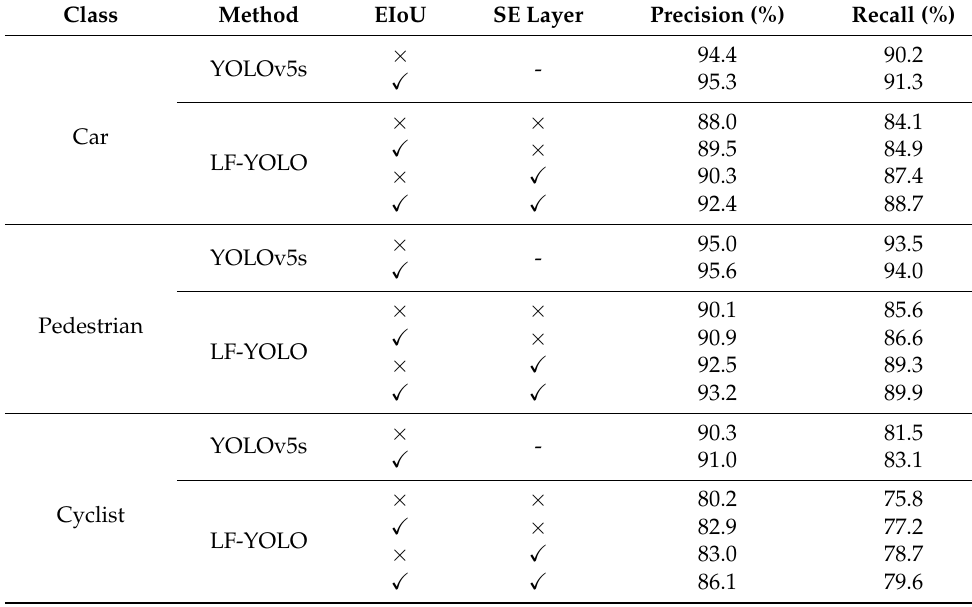
Table 1. Detection results for different network targets.